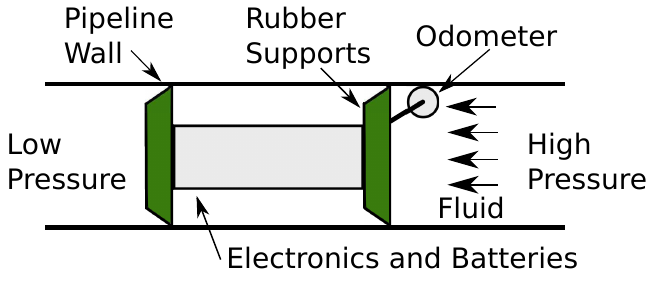
Figure 1. Example a PIG into the pipeline. Source: Lima et al.